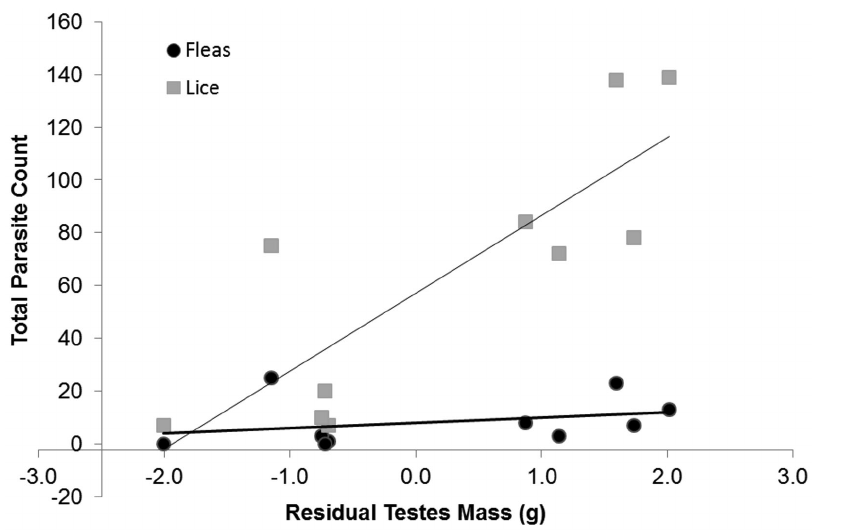
Figure 2. Relationship between residual masses of testes and total flea and lice counts for male Xerusinauris (Lice: r 2 =0.68, F 1,8 =16.97, P =0.003; Fleas: r 2 =0.10, F 1,8 =0.86, P =0.381).